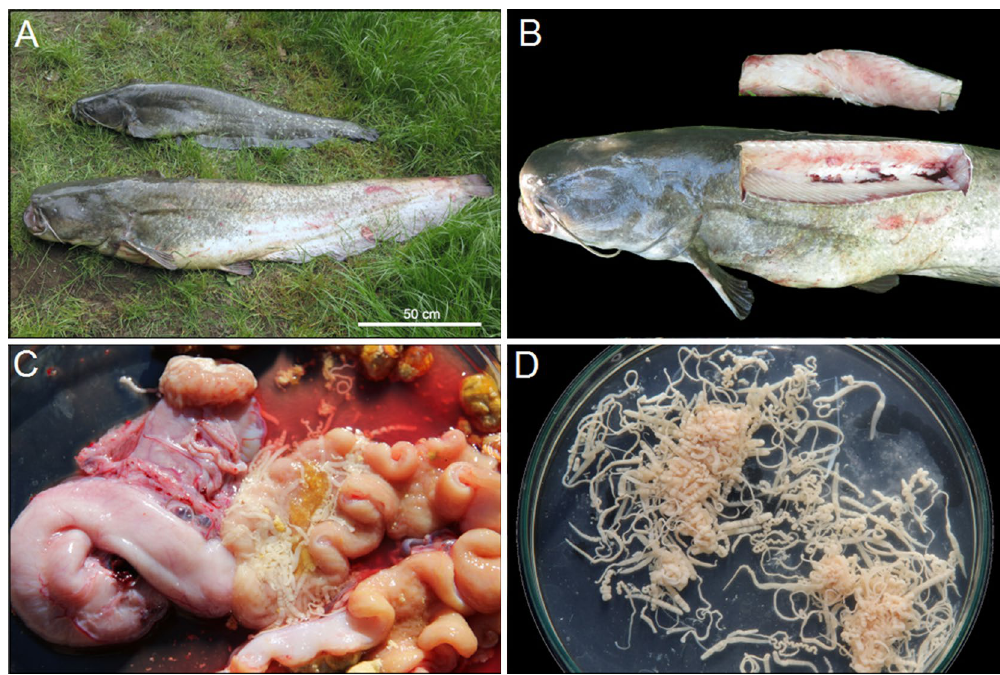
Figure 6. The Wels catfish ( Silurus glanis ) caught from the Zemplínska Šírava reservoir ( A ). Removal of part of the dorsal muscle for further determination of PCBs ( B ). The tapeworms ( Glanitaenia osculata ) in situ in the intestine of the catfish ( C ) and isolated tapeworms from the intestine washed in 0.9% saline solution ( D